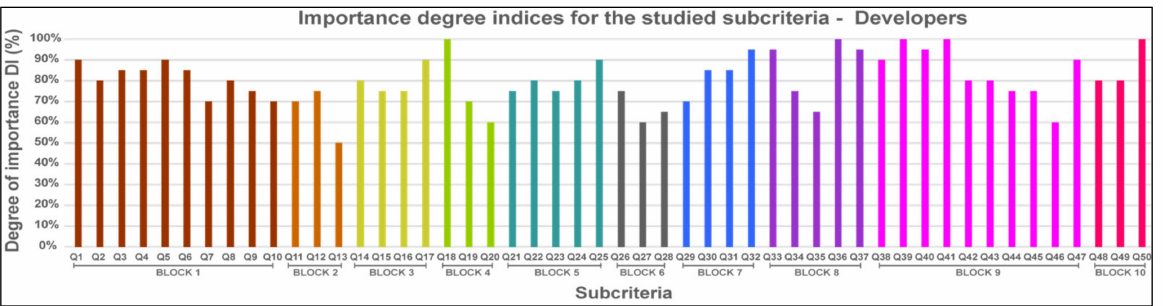
Figure 5. Bar chart showing the degree of importance (DI) of all criteria analysed (Q1 to Q50) by the business/technology developers’ experts only. Own